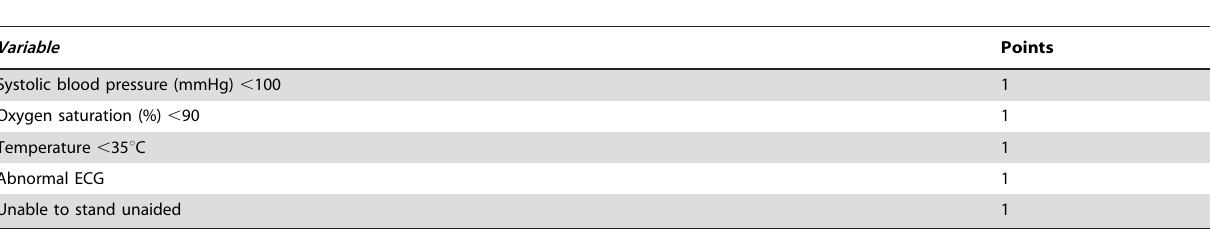
Table 2. The HOTEL